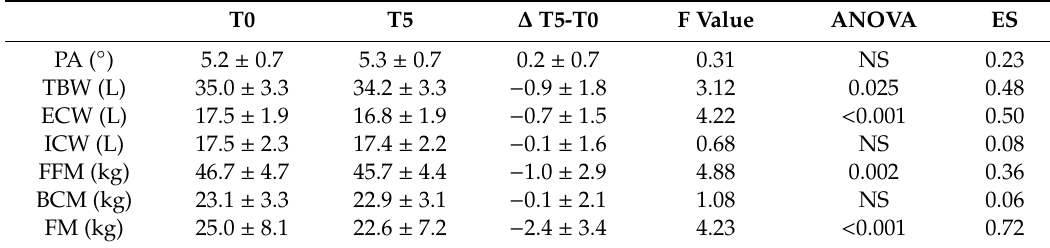
Table 2. Bio-impedance parameters during 6 months follow-up.